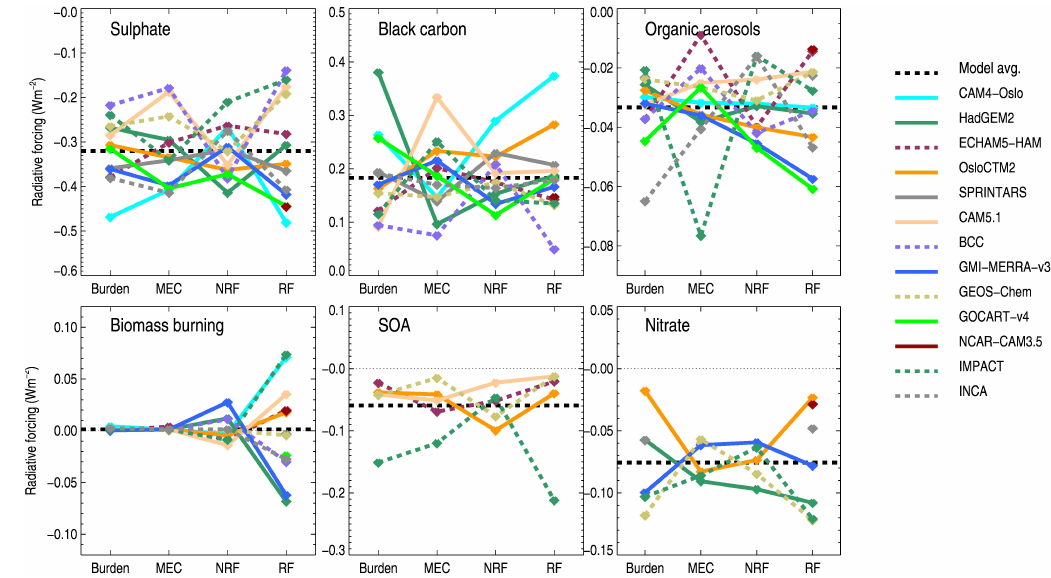
Fig. 14. Aerosol forcing partial sensitivities for the AeroCom models. The partial sensitivities are calculated as P x,n = x n / < × > ∗ < RF > , where n is model, x is either burden, MEC, NRF (with respect to AOD) or RF, <> denote mean values. Black dotted line is the mean of the AeroCom models. (Some of the results from the GISS-models are removed due to unresolved issues). Results shown for sulphate, black carbon, organic carbon, biomass burning, SOA, and nitrate as given in the